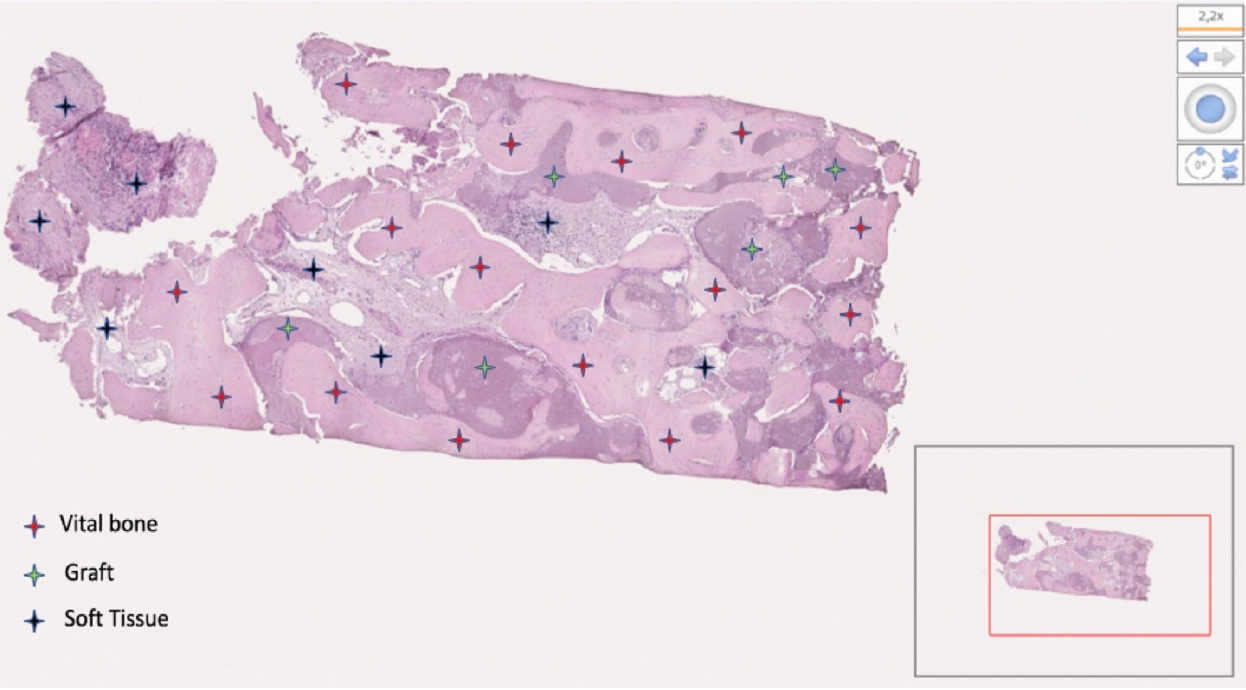
Figure 13. Bone sample taken at the upper right second premolar. The patient (number 10) re- ceived L-PRF mixed with decellularized bovine compact bone from bovine femur. The bone was 48.22%; soft tissue was 48.92%; residual graft was 2.86%.